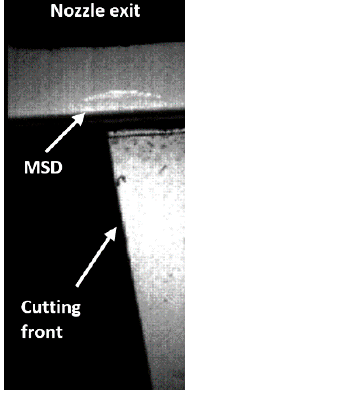
Figure 7. Shadowgraph imaging of the Mach Shock Disk (MSD) formed at the entrance of a simulated cut kerf (Lateral view of the cut slot. Supplying pressure p = 8 bar, stand-off Z = 1 mm, nozzle diameter d = 2 mm). d = 2